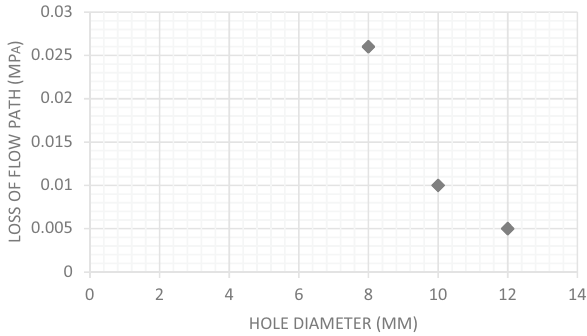
Fig. 12 Hole diameter Vs. the loss of flow path